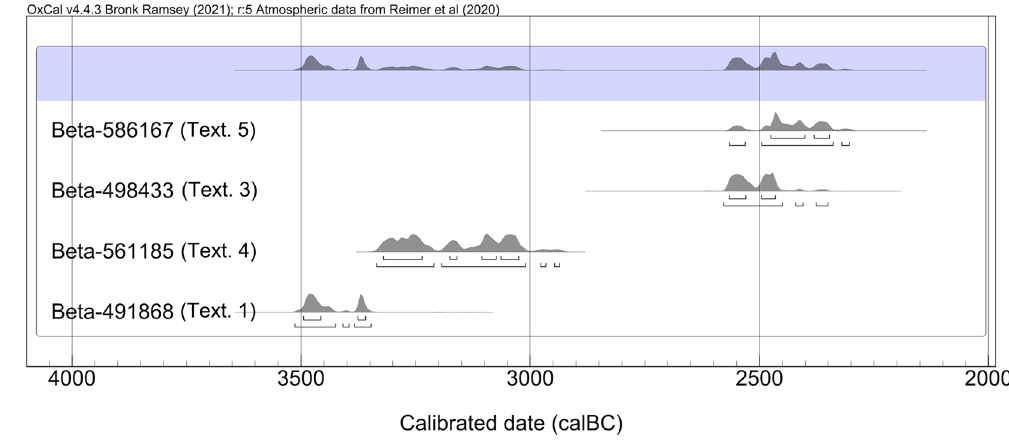
Figure 6. Multi-plot with the AMS dates obtained on four of the textiles. On top, sum of probabilities. Calibrated from the IntCal20 curve 14 . For details, see Supplementary Material Table